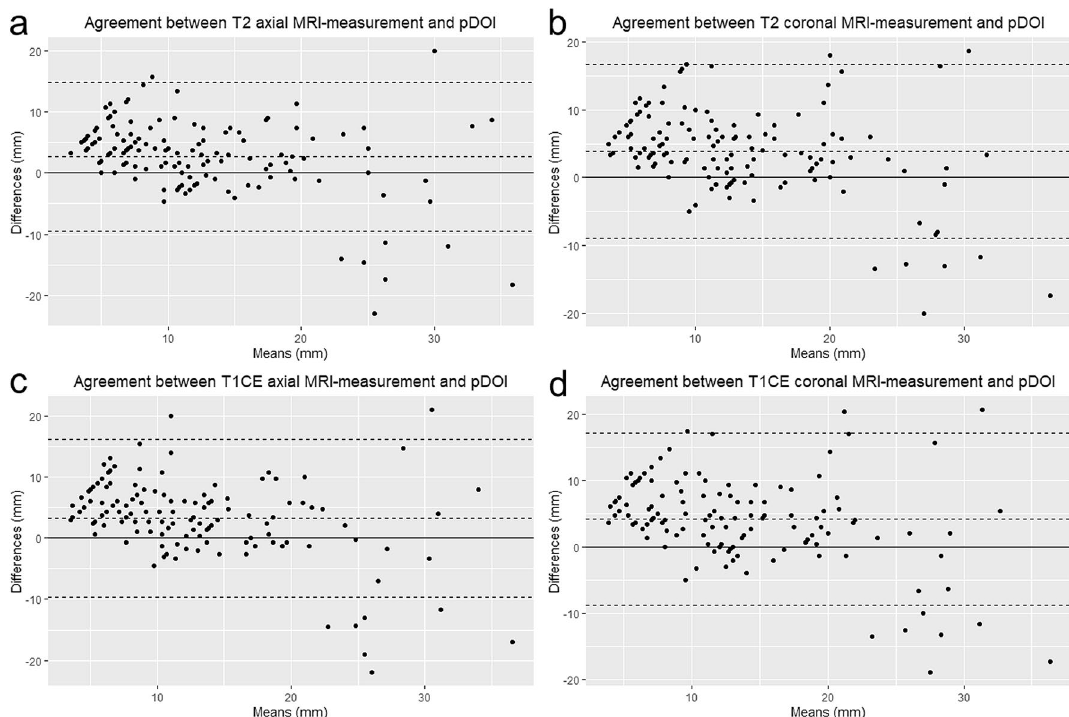
Figure 2. Bland–Altman plots illustrating the absolute differences between MRI-measured tumor thickness (MRI-TT) measured on ( a ) axial T2WI, ( b ) coronal T2WI, ( c ) axial CE-T1WI, ( d ) coronal CE-T1WI, and pathologic depth of invasion (pDOI). The central dotted horizontal line represents the mean difference whereas the upper and lower dotted horizontal lines represent the upper and lower 95% confidence intervals of agreement,